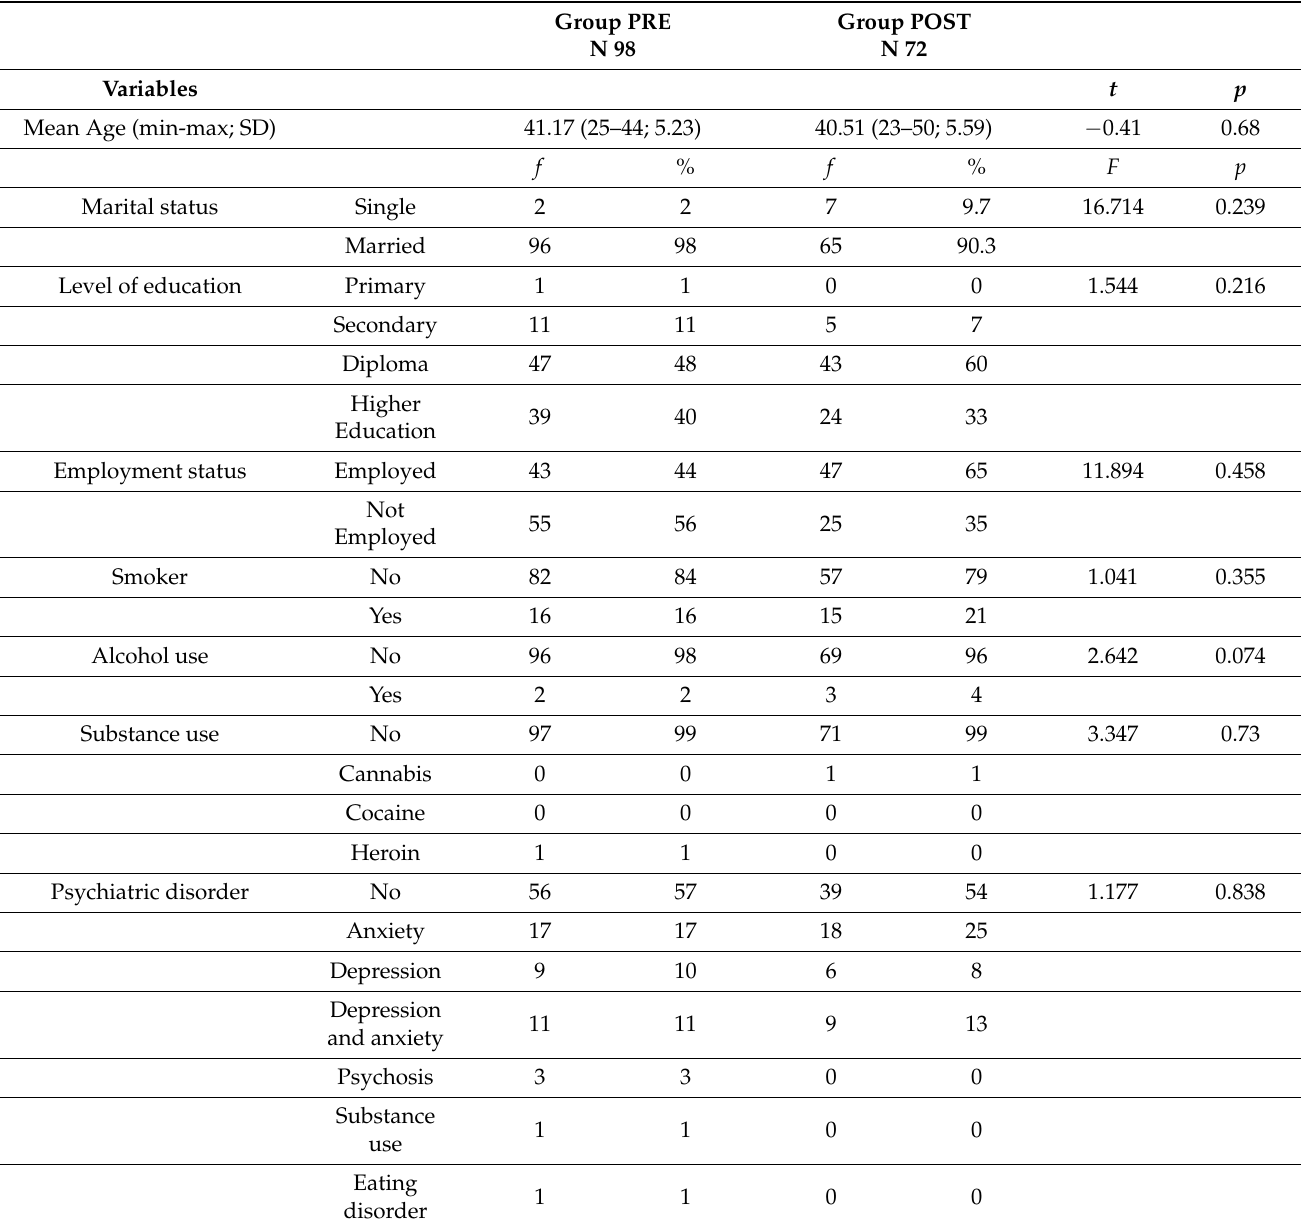
Table 1. Descriptive statistics of the two